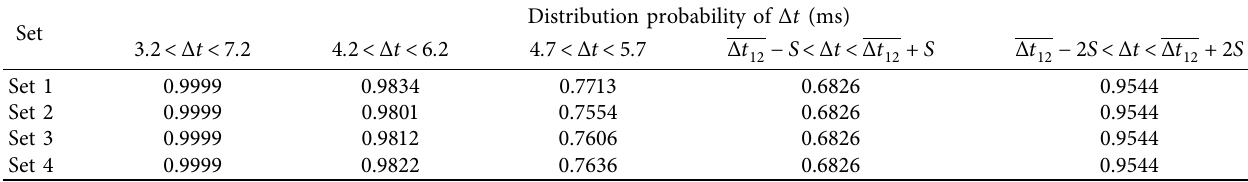
Table 2: Distribution probability of random delay ( t